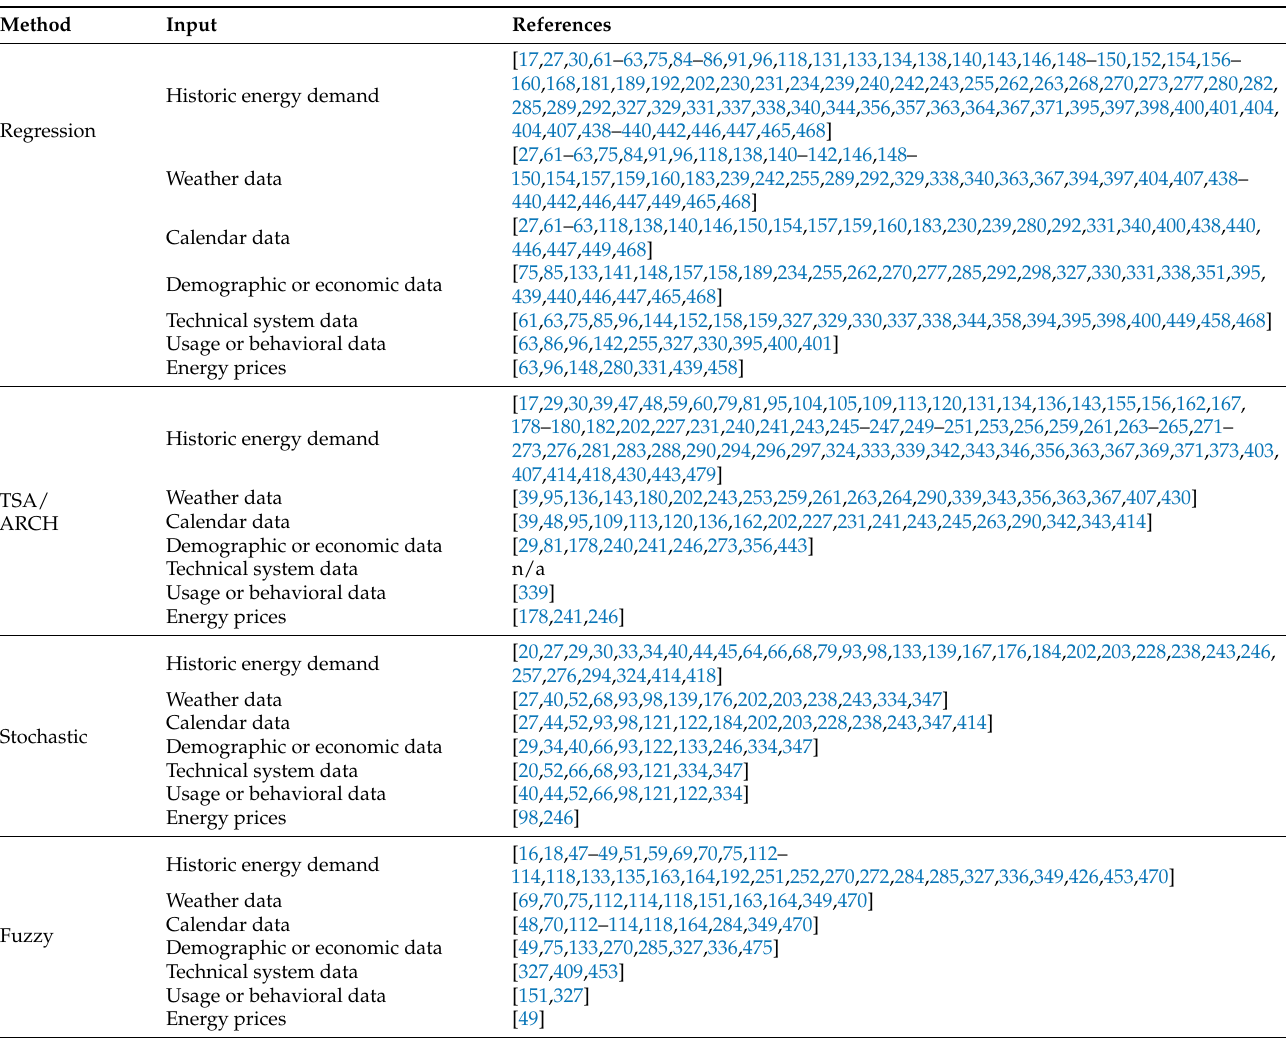
Table A6. Techniques and input data used per article (3/4). Continuation of Table A5.